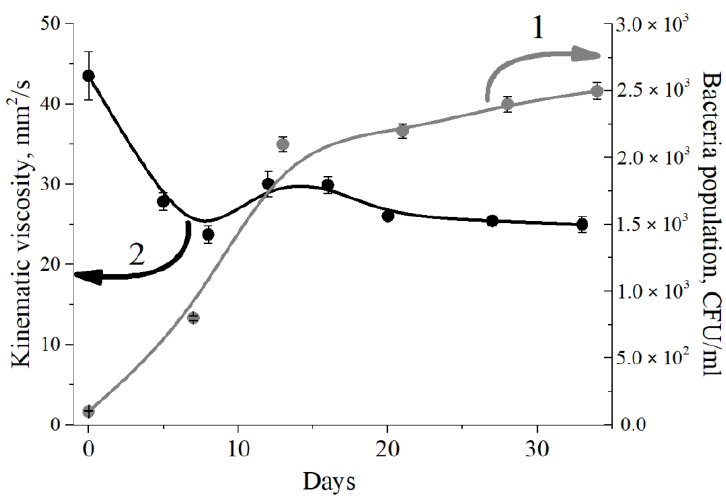
Figure 7. The number of Bacillus subtilis bacteria in 0.5 wt.% ACP# suspension, prepared in n 0.001 M phosphate buffer (pH 6.5) additionally containing Evans medium (1), and viscosity of the suspension (2) vs. time. 36